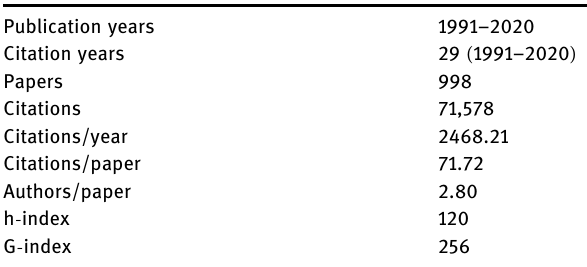
Table 2: Descriptive information about the research articles